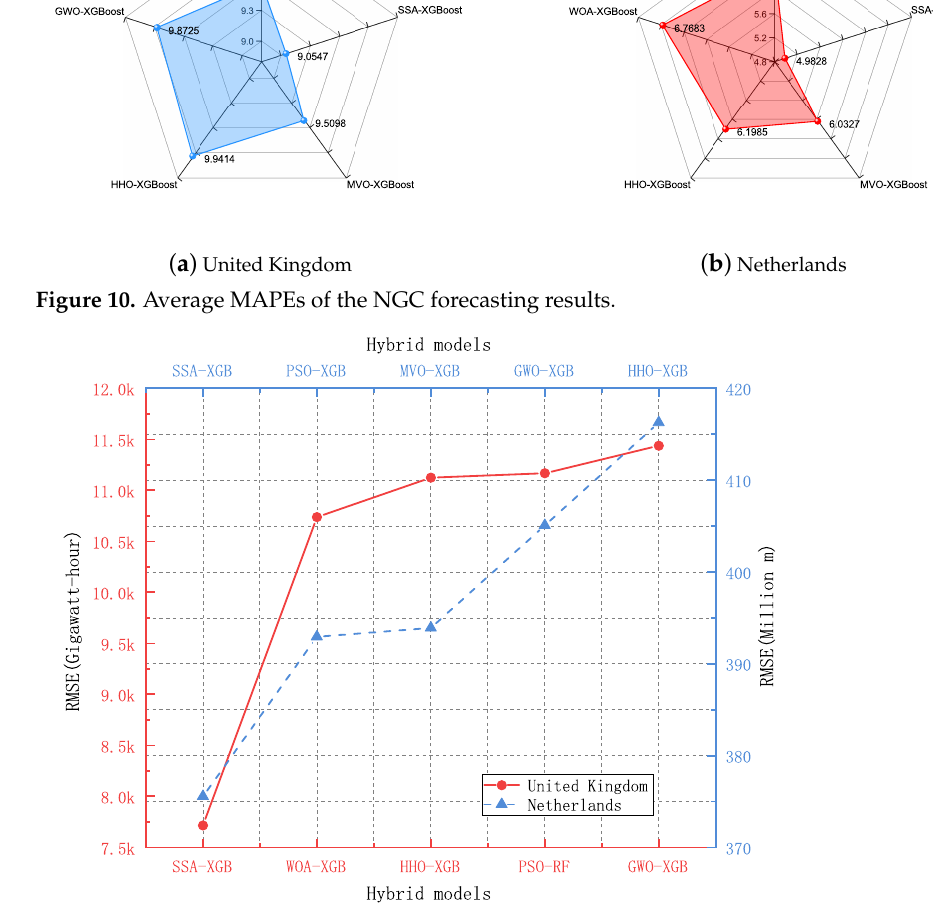
Figure 11. Average RMSEs of the NGC forecasting